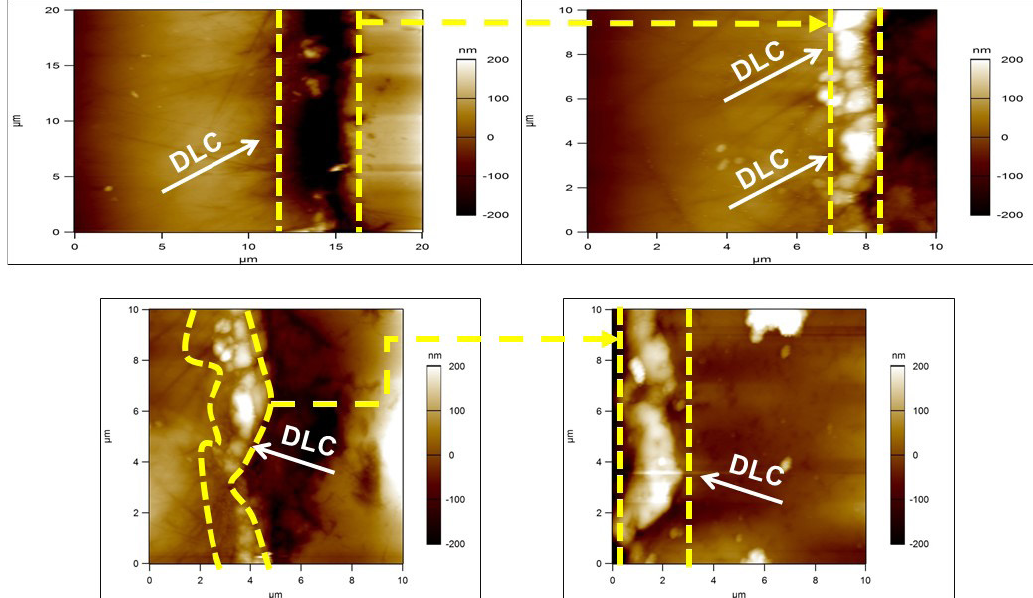
Figure 4. Thickness measurement of the DLC coating deposited on the AISI M35 HSS.